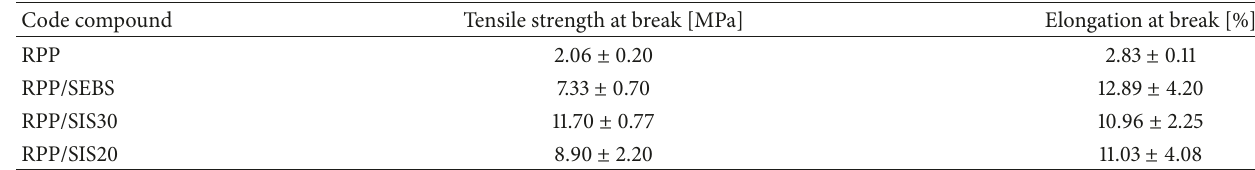
Table 7: Tensile properties for RPP/elastomer compounds and RPP.